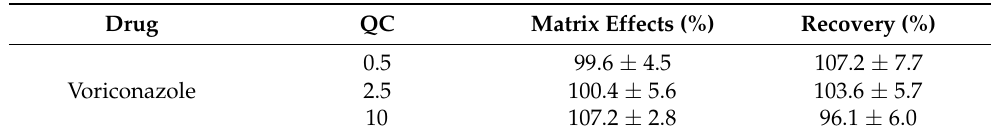
Table 3. Absolute matrix effects (%) and recoveries (%) for voriconazole (data are mean ± SD for n = 4).